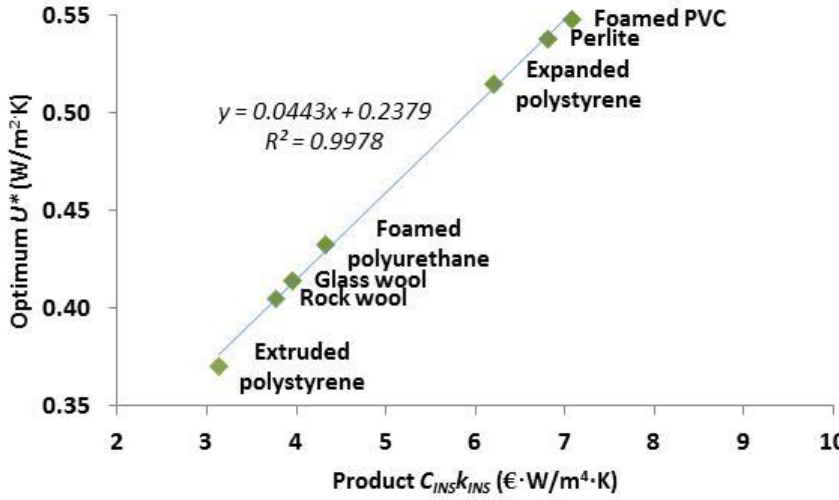
Figure 13. Correlation between the product C INS · k INS and the resulted optimum thermal transmittance U* for the alternative insulation materials.